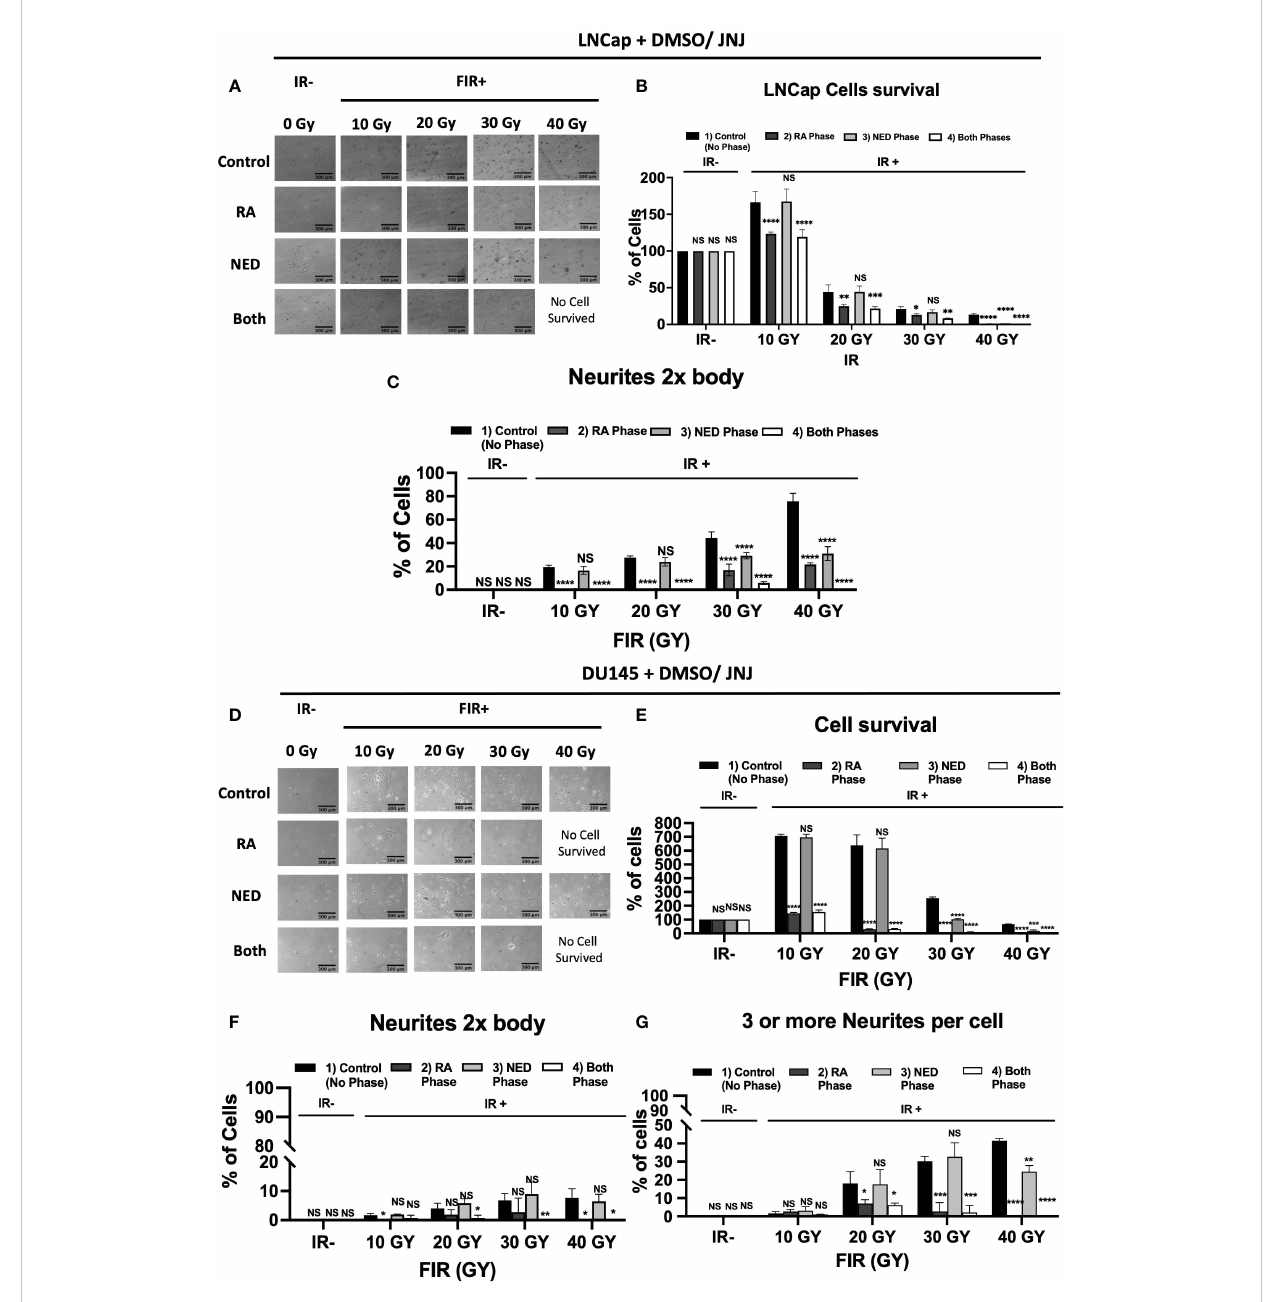
FIGURE 6 JNJ-64619178 inhibits FIR-induced Neuroendocrine differentiation (NED) in Prostate cancer. (A – C) , LNCaP cell treated with indicated cumulative doses of FIR (2Gy/dose, 5 doses/week). LNCaP cells were treated with JNJ-64619178 (1µM conc.) during the RA phase, NED phase, and both phases. (A) Phase-contrast images were captured 1 day after the last indicated dose of irradiation. (B) cell survival percentage. (C) NE-like cell (neurites 2x cell body length) percentage, calculated, analyzed, and presented. A similar experiment was done in the DU145 cell. (D – G) DU145 cells were treated with JNJ-64619178 (100 nM conc.) during the RA phase, NED phase, and both phases. (D) Phase-contrast images were captured 1 day after the last indicated dose of irradiation. (E) cell survival percentage. (F) NE-like cell (neurites 2x cell body length) (G) NE-like cell (more than 3 neurites/cell body) percentage, calculated, analyzed, and presented. For statistical analysis two-way ANOVA was performed, each bar in (B – G) are mean of SD of n=3 independent experiment (*P ≤ 0.05; **P ≤ 0.01; ***P ≤ 0.001; ****P ≤ 0.0001; NS, P >